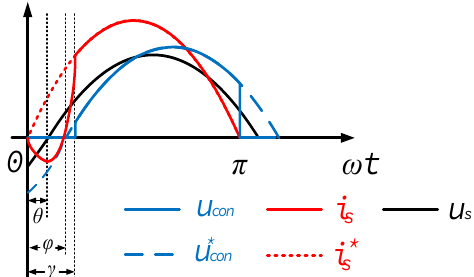
Figure 7. Expected waveforms and actual waveforms of the AC-side fundamental voltage and current with synchronous drive under a leading power factor.